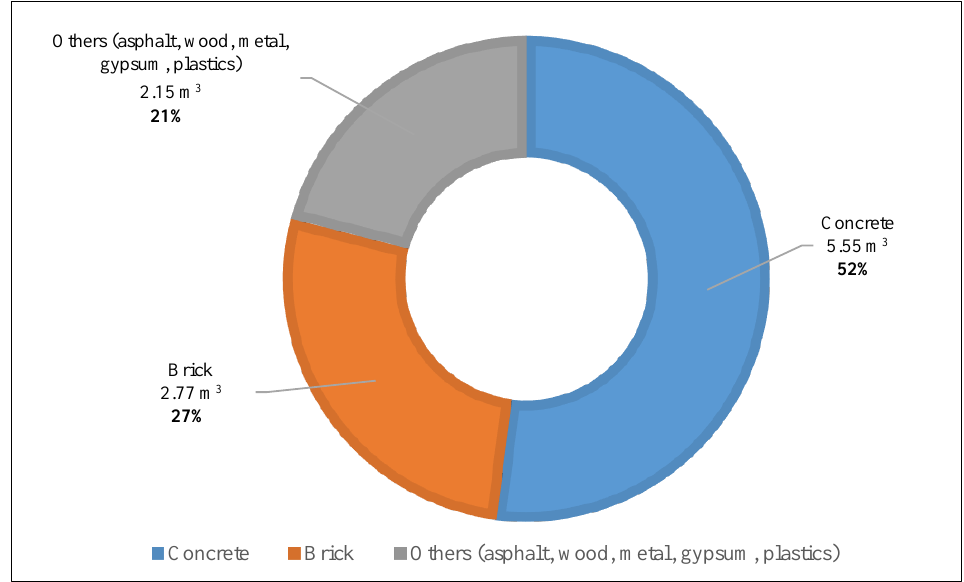
Figure 3. CDW generated at the construction